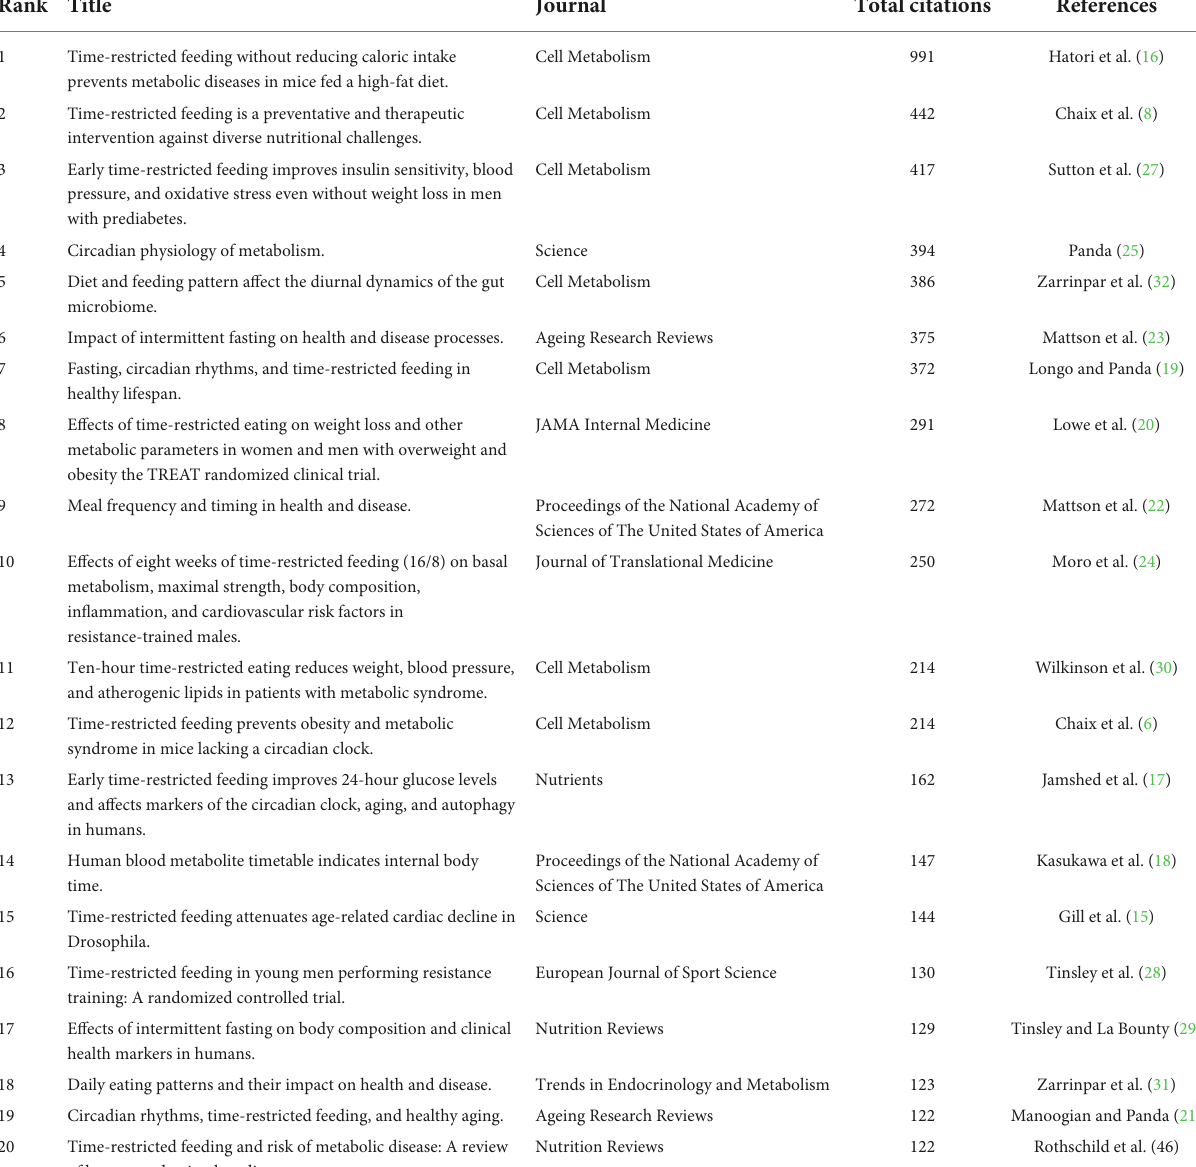
TABLE 3 Ranking of the top 20 highest cited